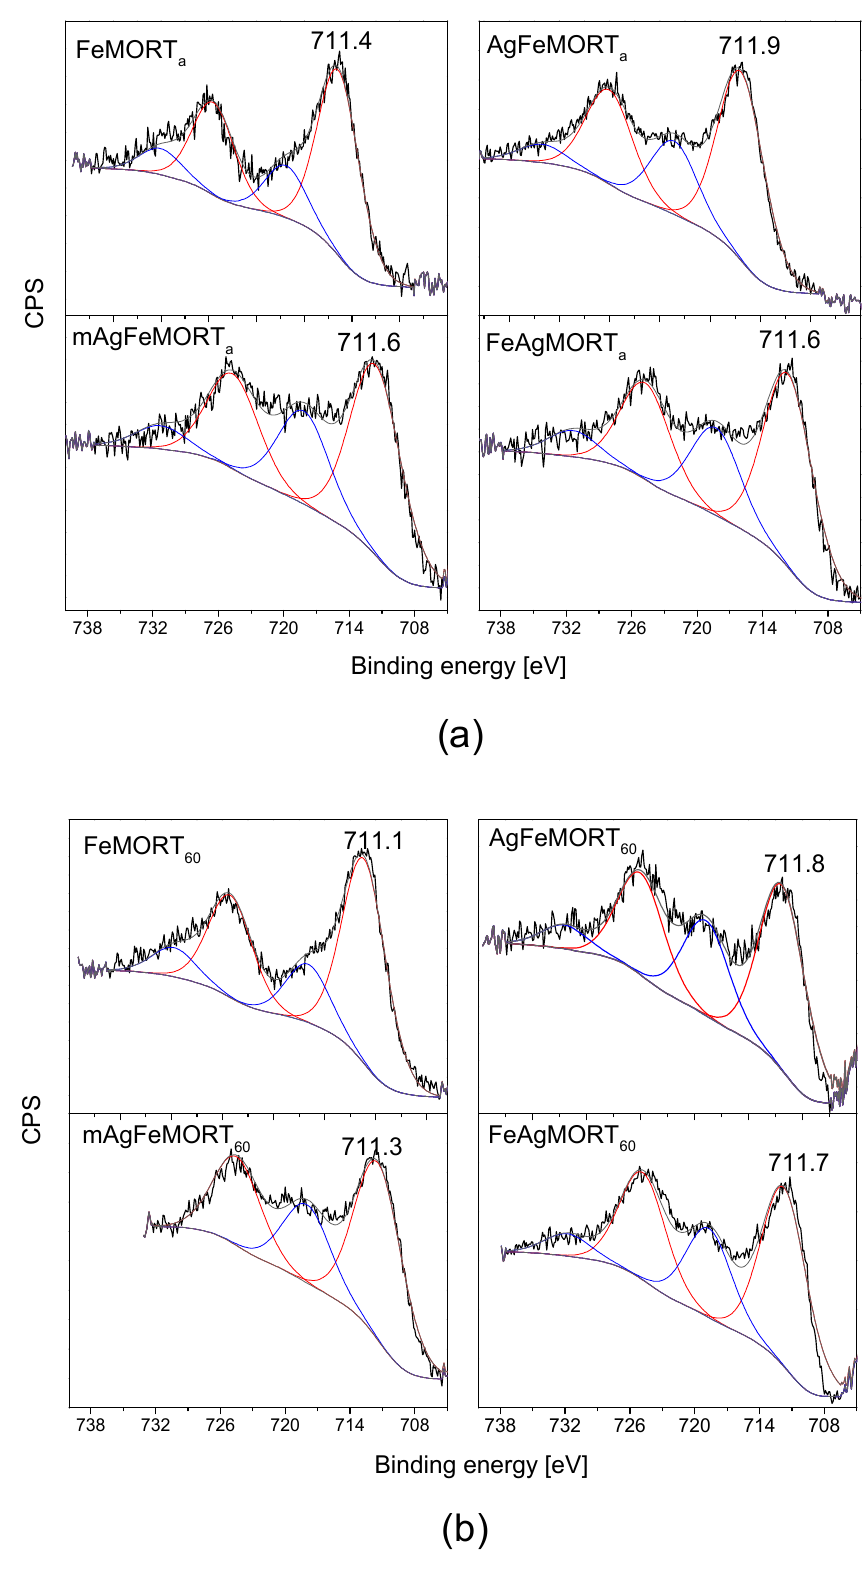
Figure 3. Fe 2p 3/2 photoelectron spectra of mono- and bimetallic samples prepared at: ( a ) room temperature, and ( b ) 60 °C.